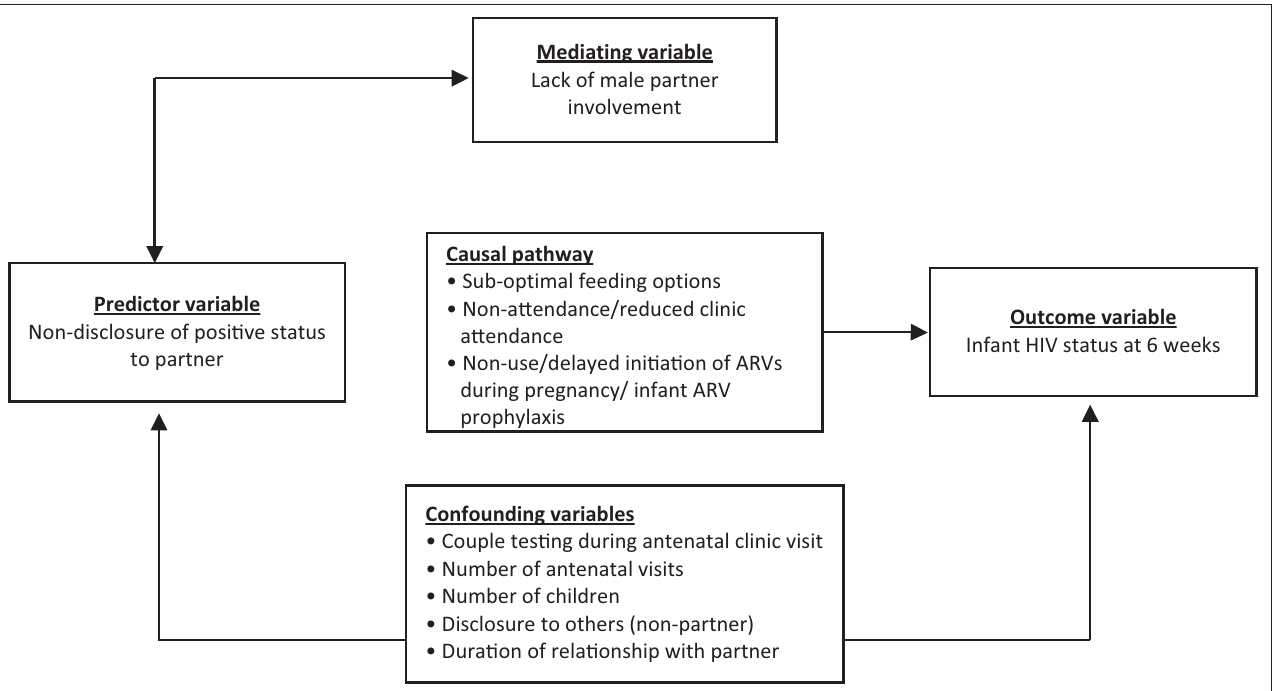
FIGURE 1: Conceptual framework for relationship among variables affecting non-disclosure and mother-to-child transmission of